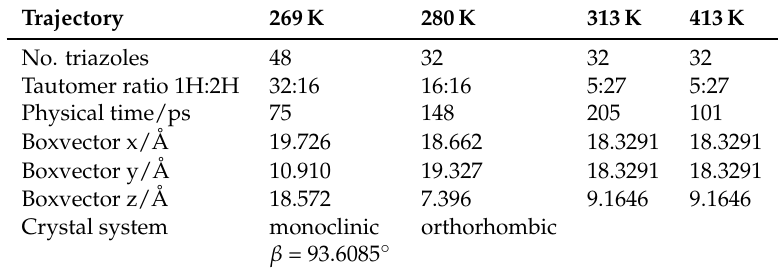
Table 2. Computational setup of all produced ab-initio molecular dynamics trajectories.